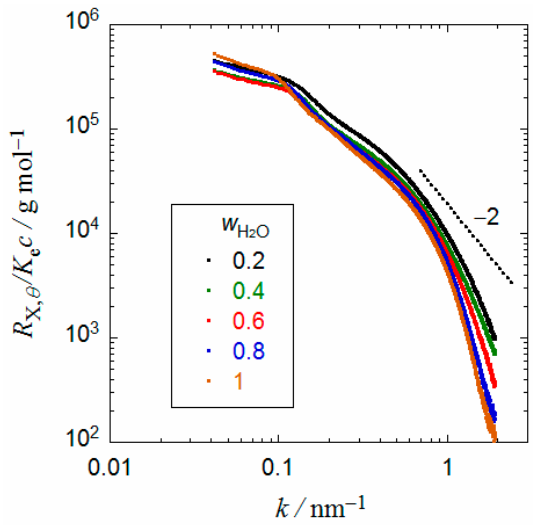
Figure 4. SAXS profiles of PFSI in water and water-MeOH mixtures at c = 0.005 g/cm 3 at 25 °C.